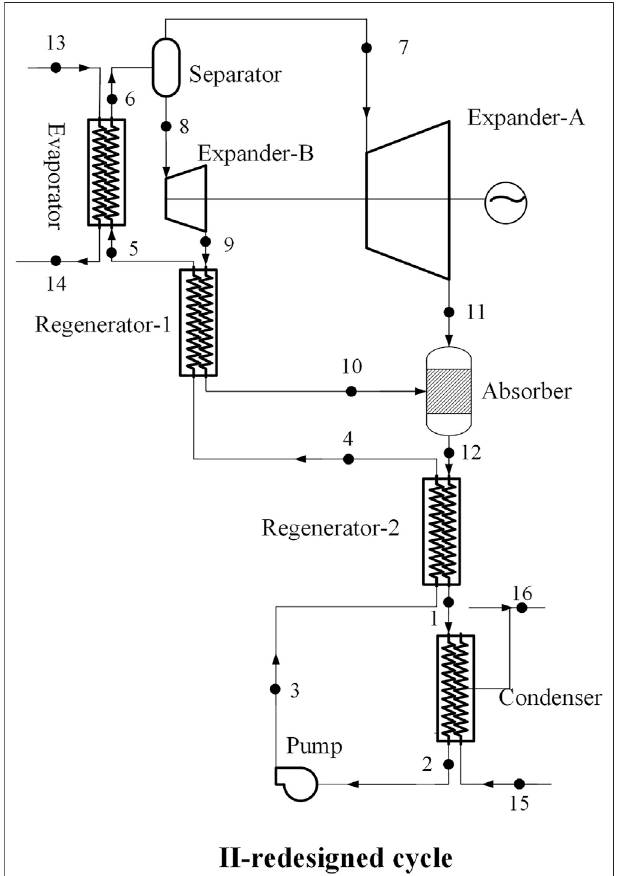
FIGURE 3 | The schematic diagram of I-redesigned cycle.